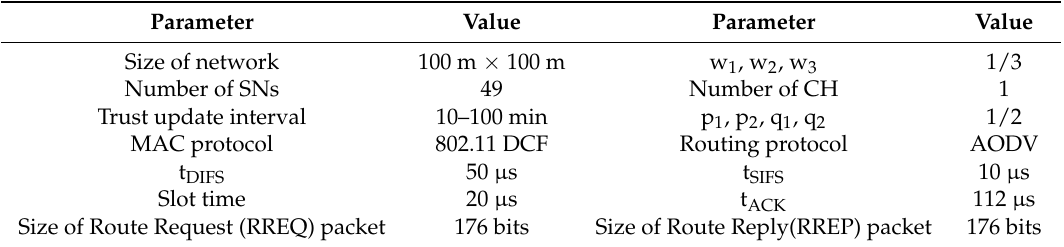
Table 1. Assumed values of system parameters. MAC = medium access control, AODV = Ad-hoc On-Demand